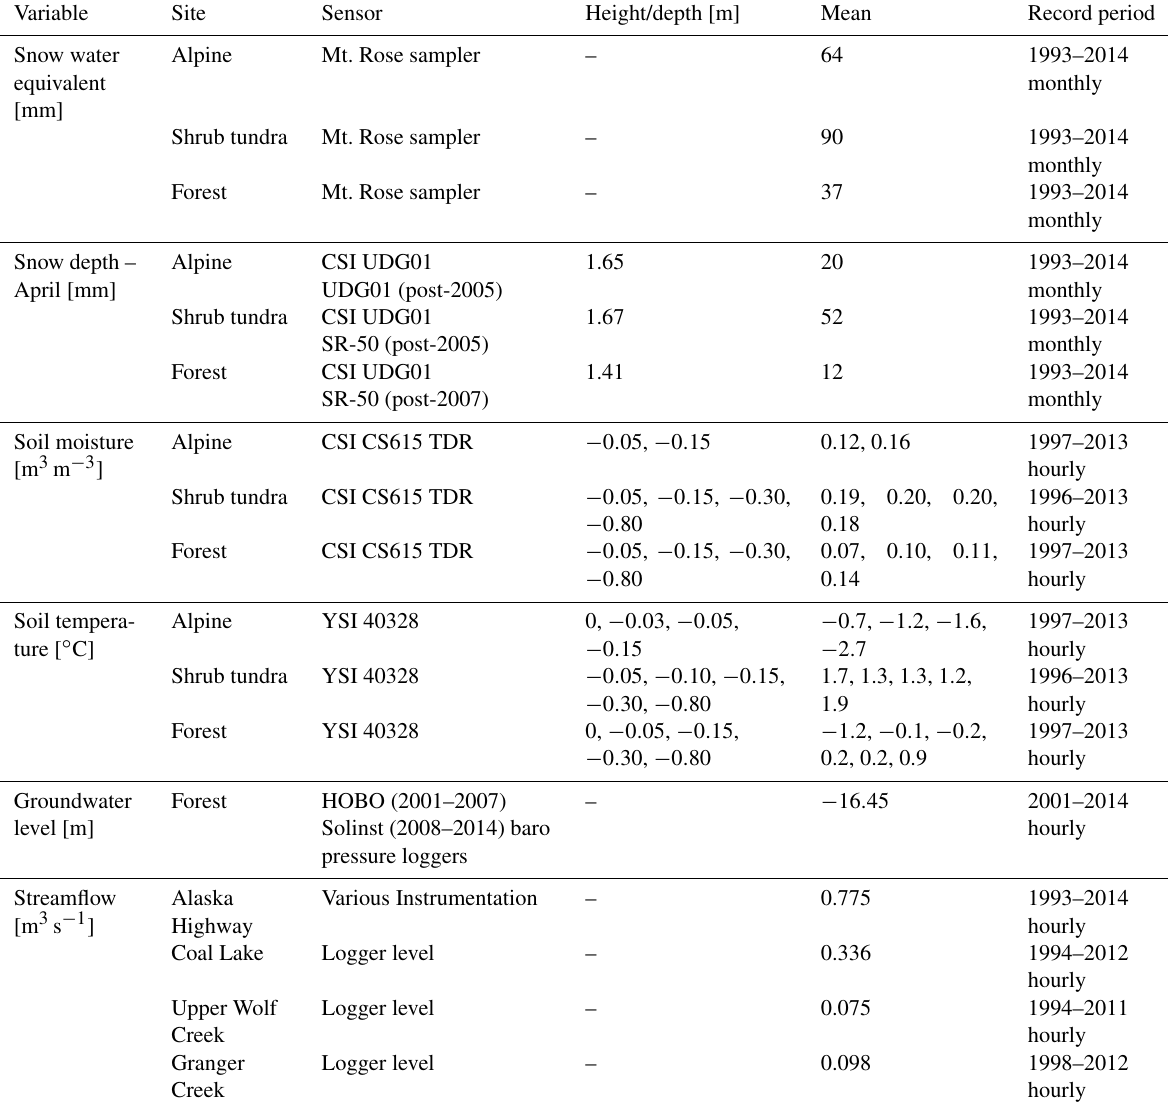
Table 3. Hydrological data measured in the basin including variables, climatological water year mean values, current sensors, and measurement height. Negative heights show below ground